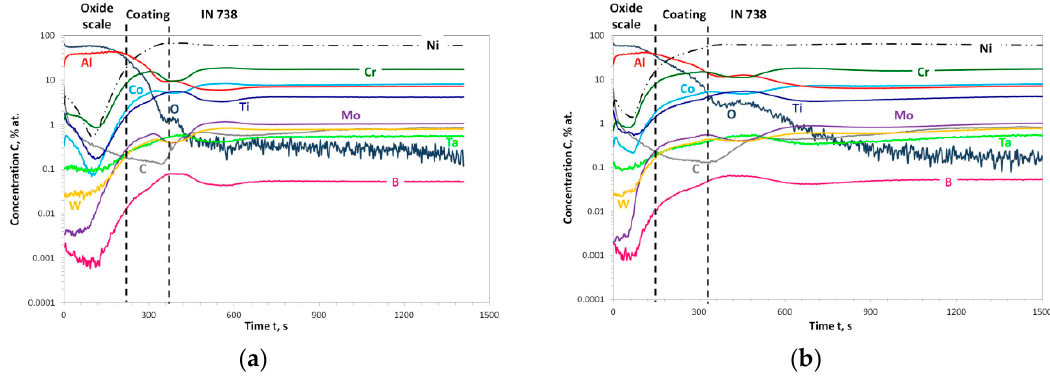
Figure 16. The GD-OES depth profile obtained for aluminide layer formed on: ( a ) Ground and ( b ) grit-blasted IN 738 after 200 cycles of a thermal shocking test.